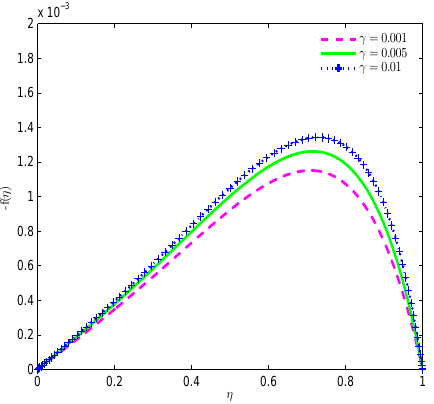
Fig. 12: Variation of electric potential distribution ψ with K